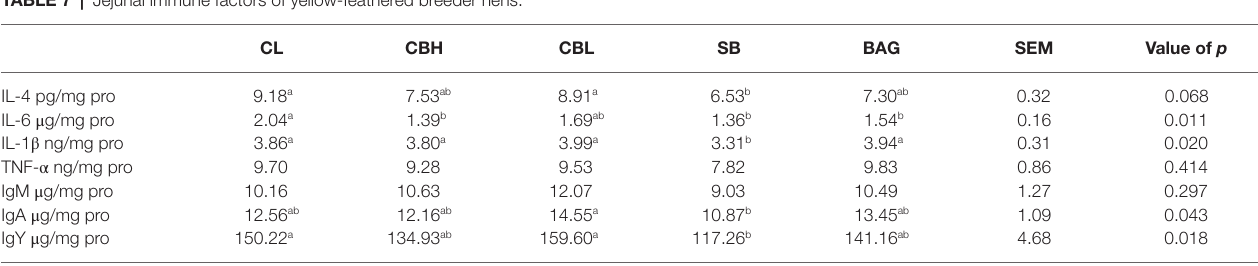
TABLE 7 | Jejunal immune factors of yellow-feathered breeder hens.